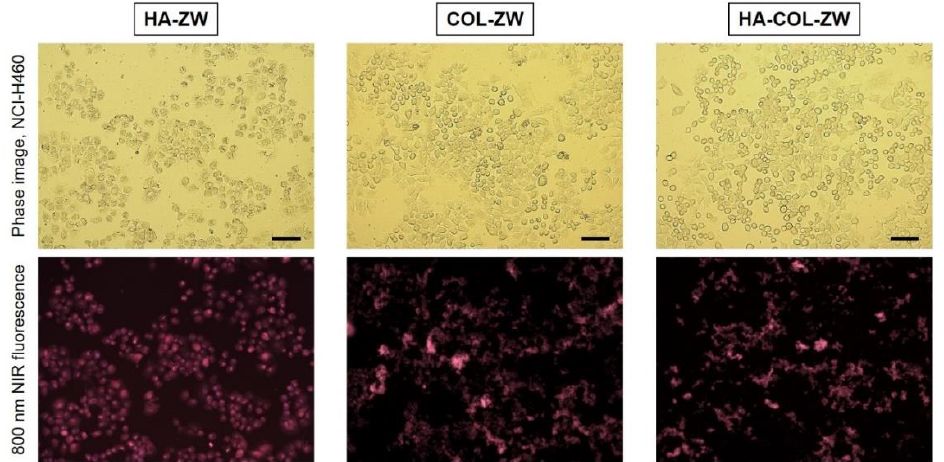
Figure 5. Live cancer cell binding of HA-ZW, COL-ZW, and HA-COL-ZW using the NCI-H460 cell line. In vitro NIR fluorescence imaging is conducted after treatment with 2 µ M of each sample. The sample concentrations are determined by the concentrations of the ZW800-AM and ZW800-1 NIR dyes. Images are representative of N = 3 independent experiments. All NIR fluorescence images have identical exposure times and normalization. Scale bars = 100 µ